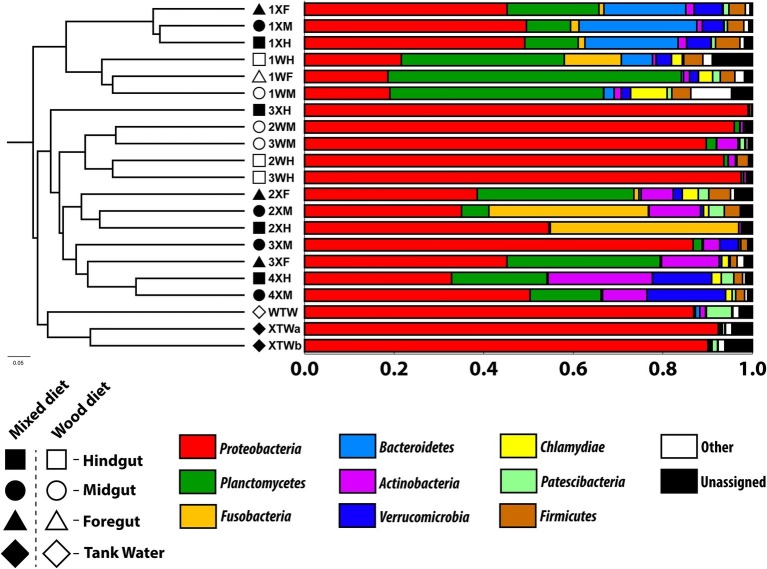
Unweighted pair group method with arithmetic mean (UPGMA) tree based on Bray-Curtis distance analysis. Bar graph represents the relative abundance of predominant bacterial phyla in the tank water (TW, diamond) as well as fore (F, triangle), mid (M, circle), and hindguts (H, square) of P. nigrolineatus fed either a wood (W, open symbols) or mixed diet (X, closed symbols). OTUs were picked using the SILVA_132 16S database (OTU ID =0.97).